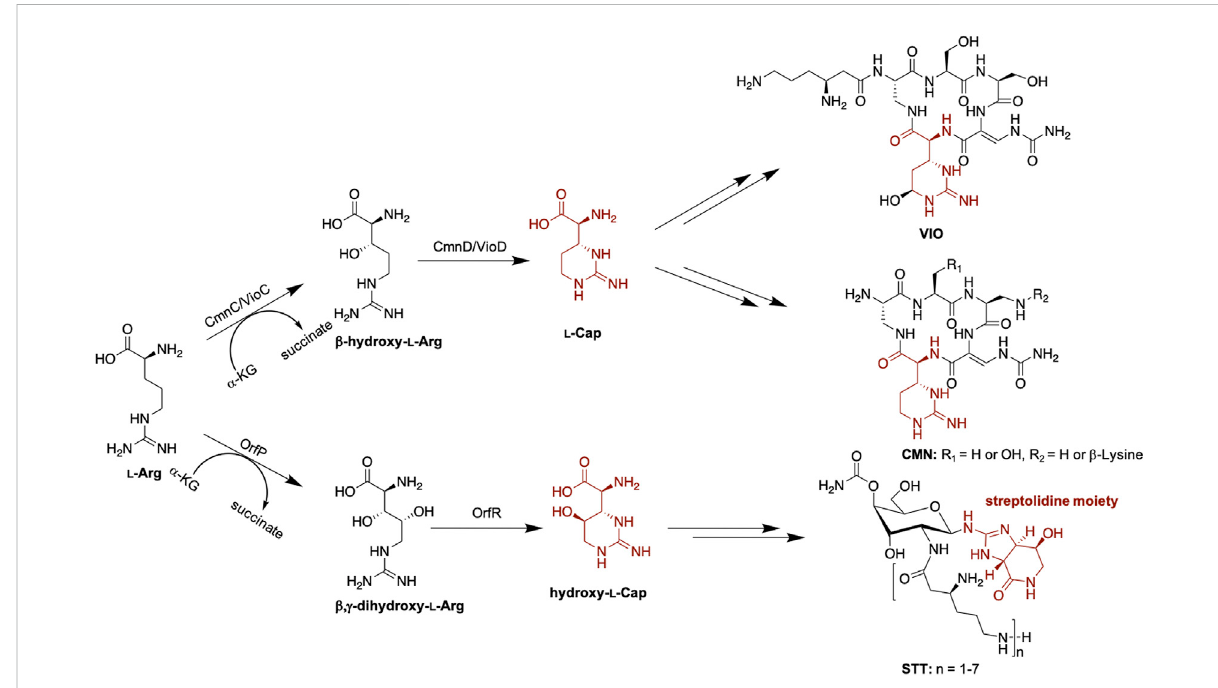
FIGURE 1 Proposed biosynthesis of L -Cap in VIO, CMN, and STT biosynthetic pathways. Hydroxy- L -Cap is an intermediate to form the streptolidine moiety in STT biosynthesis.